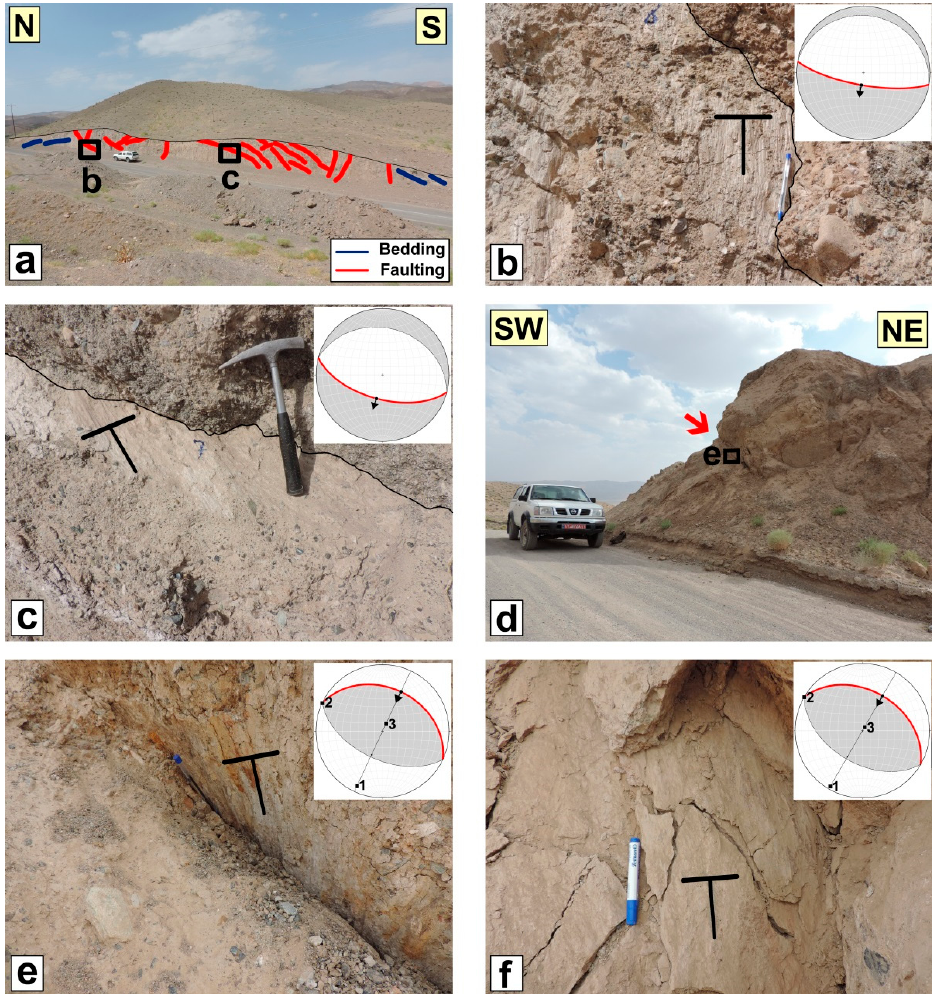
Figure 9. Field images of the normal faults, and the Nasrabad fault in the southern front of the Bagheran mountain. ( a ) The normal faulting within the hanging-wall anticline related to the east Gol Gol fault. ( b , c ) Close-up view of the two normal faults with the mean attitudes of N80°W, 75°SW and N75°W, 60°SW. ( d ) Trace of the Nasrabad fault among the Neogene units and Quaternary deposits. ( e , f ) Close-up view of the Nasrabad faults with mean attitudes of N65°W, 35°NE and N30°W, 40°NE, which show striations of 025°/35° and 030°/40°, respectively (see locations on Figure 1c,d).